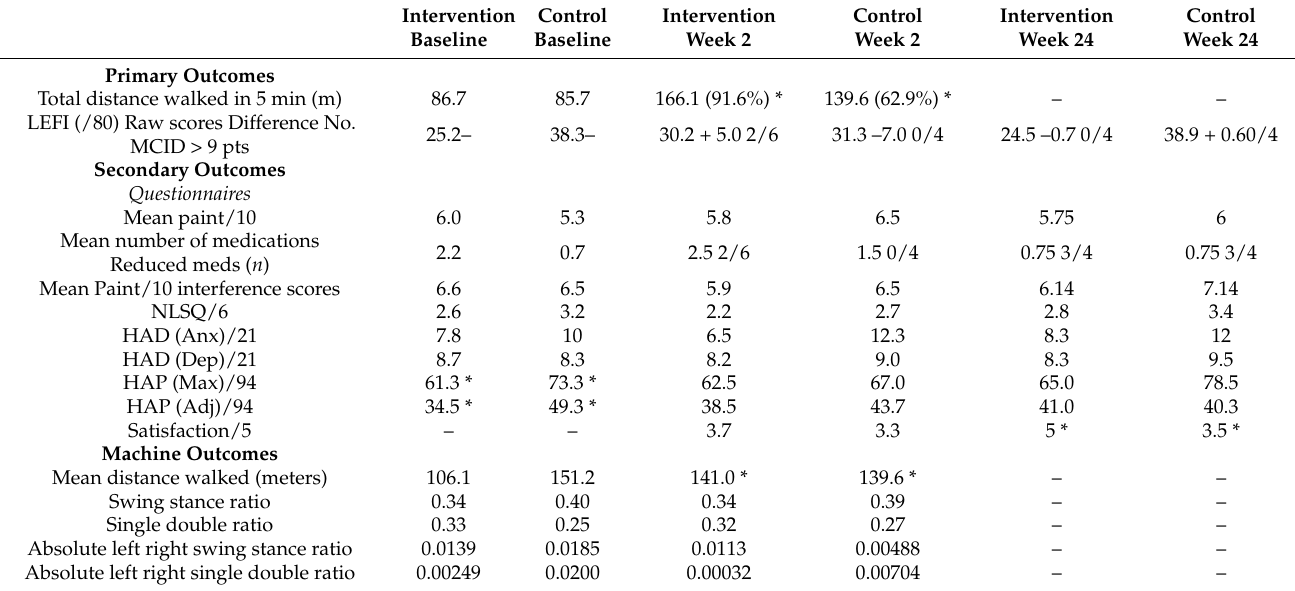
Table 2. Primary and Secondary Outcomes from